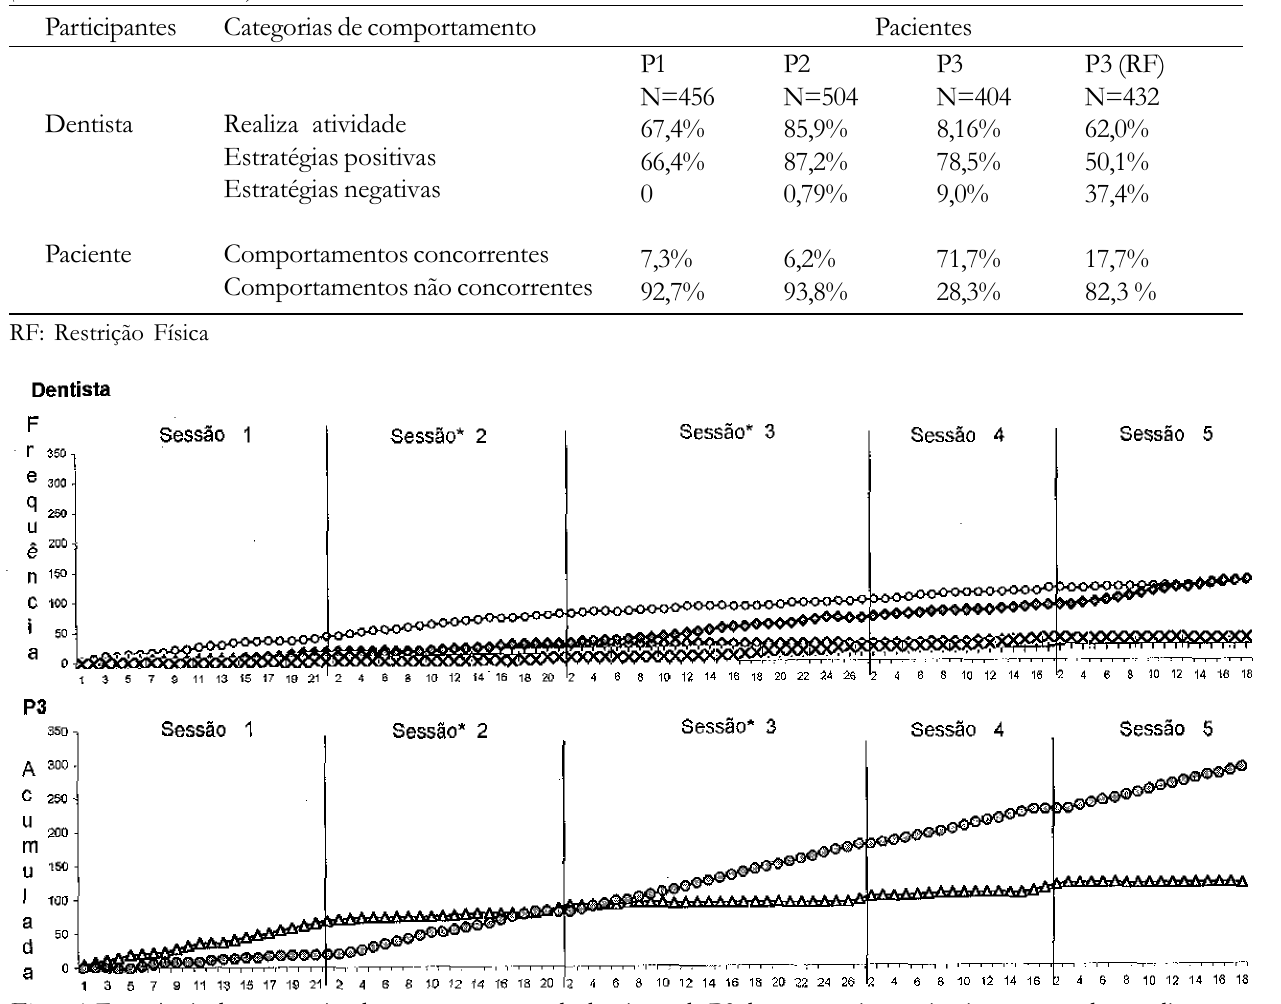
Figura 1. Freq(cid:252)Œncia das categorias de comportamento da dentista e de P3 durante as cinco primeiras sessıes de atendimento. As categorias do dentista foram: Realiza Atividade, Dire(cid:231)ªo, Tranq(cid:252)iliza(cid:231)ªo, Distra(cid:231)ªo, Persuasªo e Puni(cid:231)ªo Verbal. Em rela- (cid:231)ªo a P3 as categorias foram: Colabora(cid:231)ªo e Nªo Colabora(cid:231)ªo. Nas sessıes com aster(cid:237)scos a crian(cid:231)a tinha recebido 0,3mg de Diazepam por Kg de